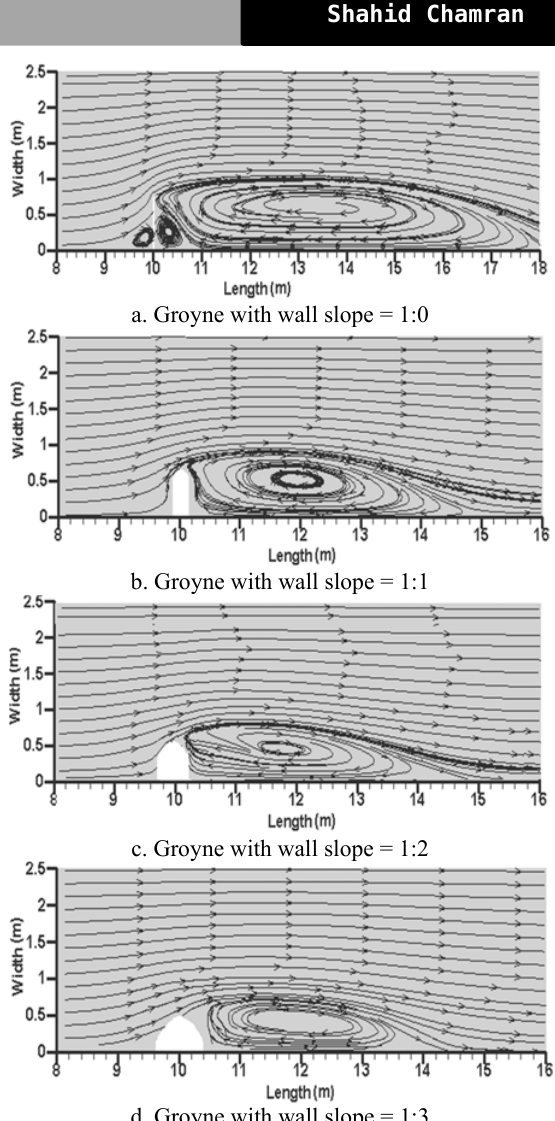
Fig.14 Streamlines at z= 0.175m for the bed